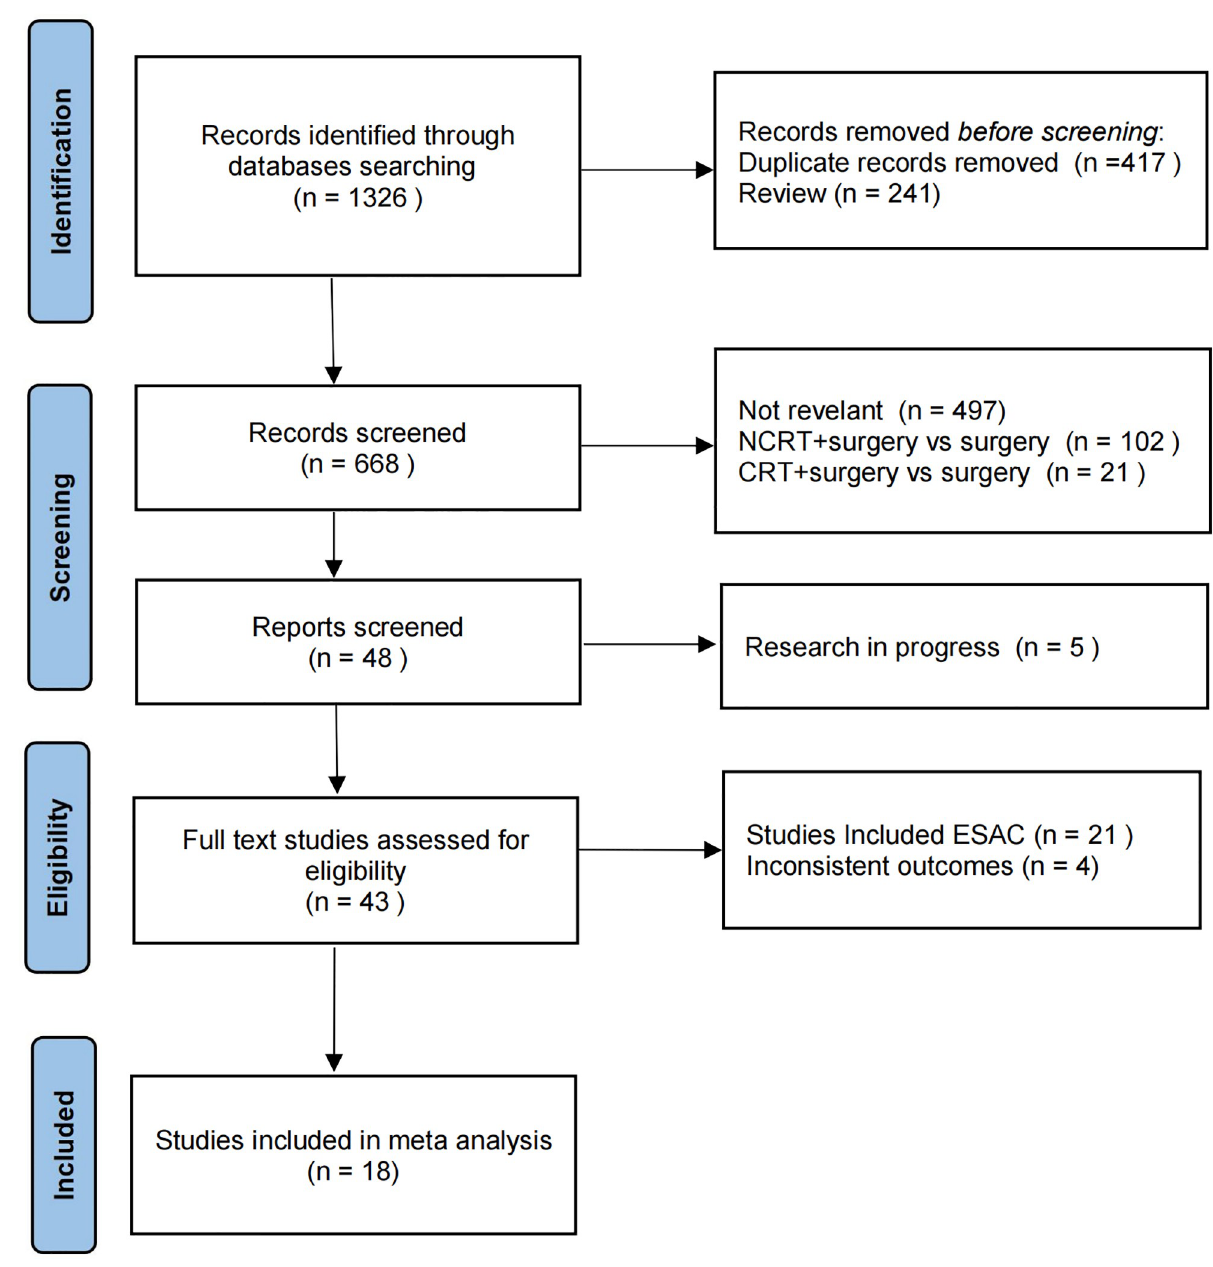
Fig 1. Flow chart of studies screening.